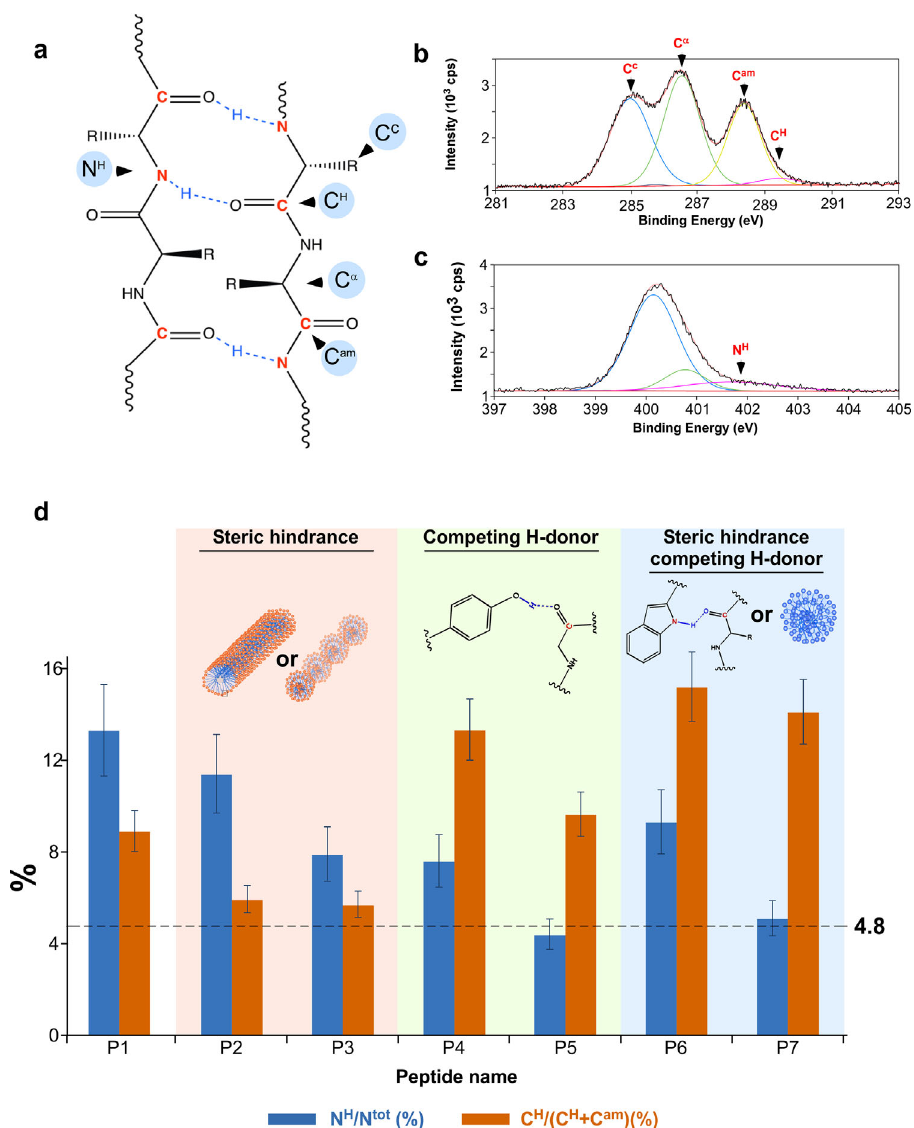
Fig. 3 Analysis of H-bonded network formation using X-ray photoelectron spectroscopy. a Schematic representation of H-bond formation between the carbonyl of the peptide backbone in one β -strand and the NH of the peptide backbone in another β -strand. b Carbon XPS spectrum of P1 showing its different oxidation states. Most interestingly, fi ngerprints of the H-bond formation can be extracted. c Nitrogen XPS spectrum of P1, showing different oxidation states, viz., the bare NH in an amide/peptide backbone and that of NH involved in H-bond formation. d Histogram showing the percentage of H- bond formation as expressed by the N 1 s spectrum and by the C am signal, evaluated for the entire set of polymers. Error bars STDV.